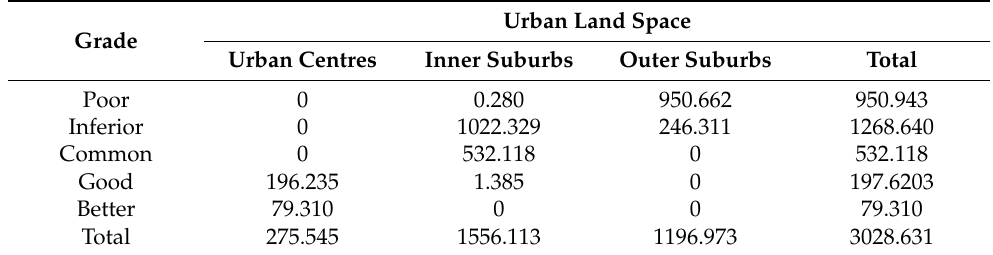
Table 6. Area statistics of different regional grades of carrying capacity in urban land space (km 2 ). Urban Land Space Grade Urban Centres Inner Suburbs Outer